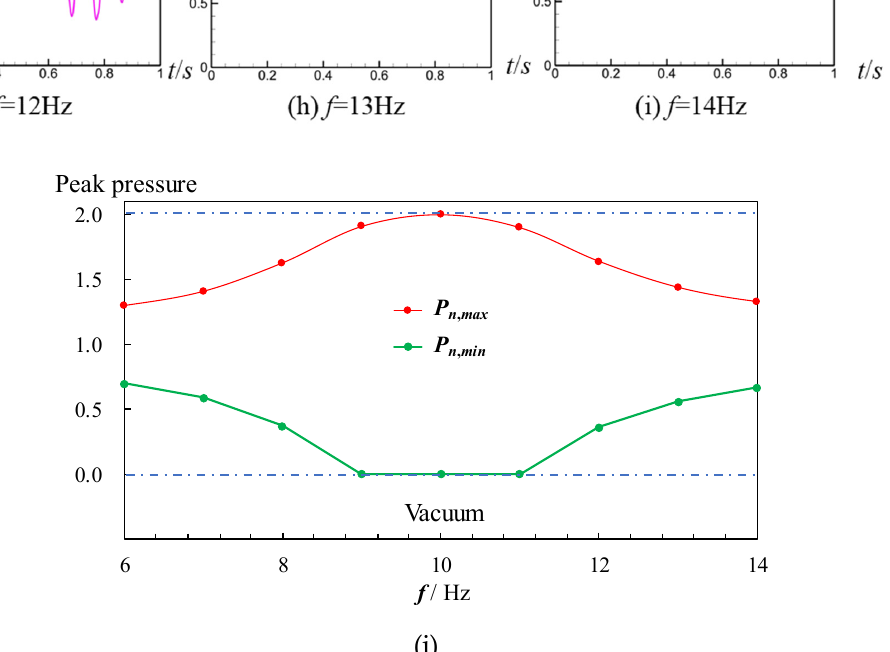
Figure 6. Normalized pressure–time P n curves at inlet and endpoint when L x = 25 m: ( a ) f = 6 Hz, ( b ) f = 7 Hz, ( c ) f = 8 Hz, ( d ) f = 9 Hz, ( e ) f = 10 Hz, ( f ) f = 11 Hz, ( g ) f = 12 Hz, ( h ) f = 13 Hz, ( i ) f = 14 Hz. ( j ) Relationship between the normalized peak pressure P n , max , P n , min and frequency f at endpoint. All normalized pressures are dimensionless